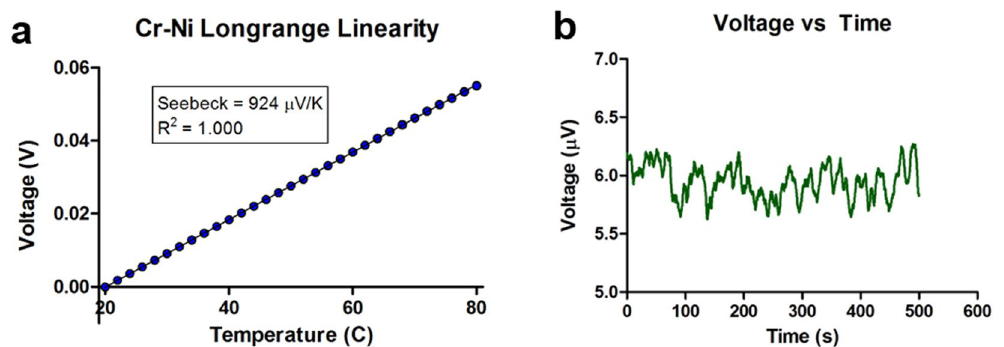
Figure 4. Performance of the chrome-on-silicon thermocouple. ( a ) Thermal voltage vs temperature measurements were made with the cold end constantly held at 20 °C. The device produces linear output between 20 °C and 80 °C. ( b ) Noise measurements - voltage output of the thermocouple over time at a constant temperature. This helps us find the noise floor of the device. The standard deviation of the noise measurements was 0.143 µ